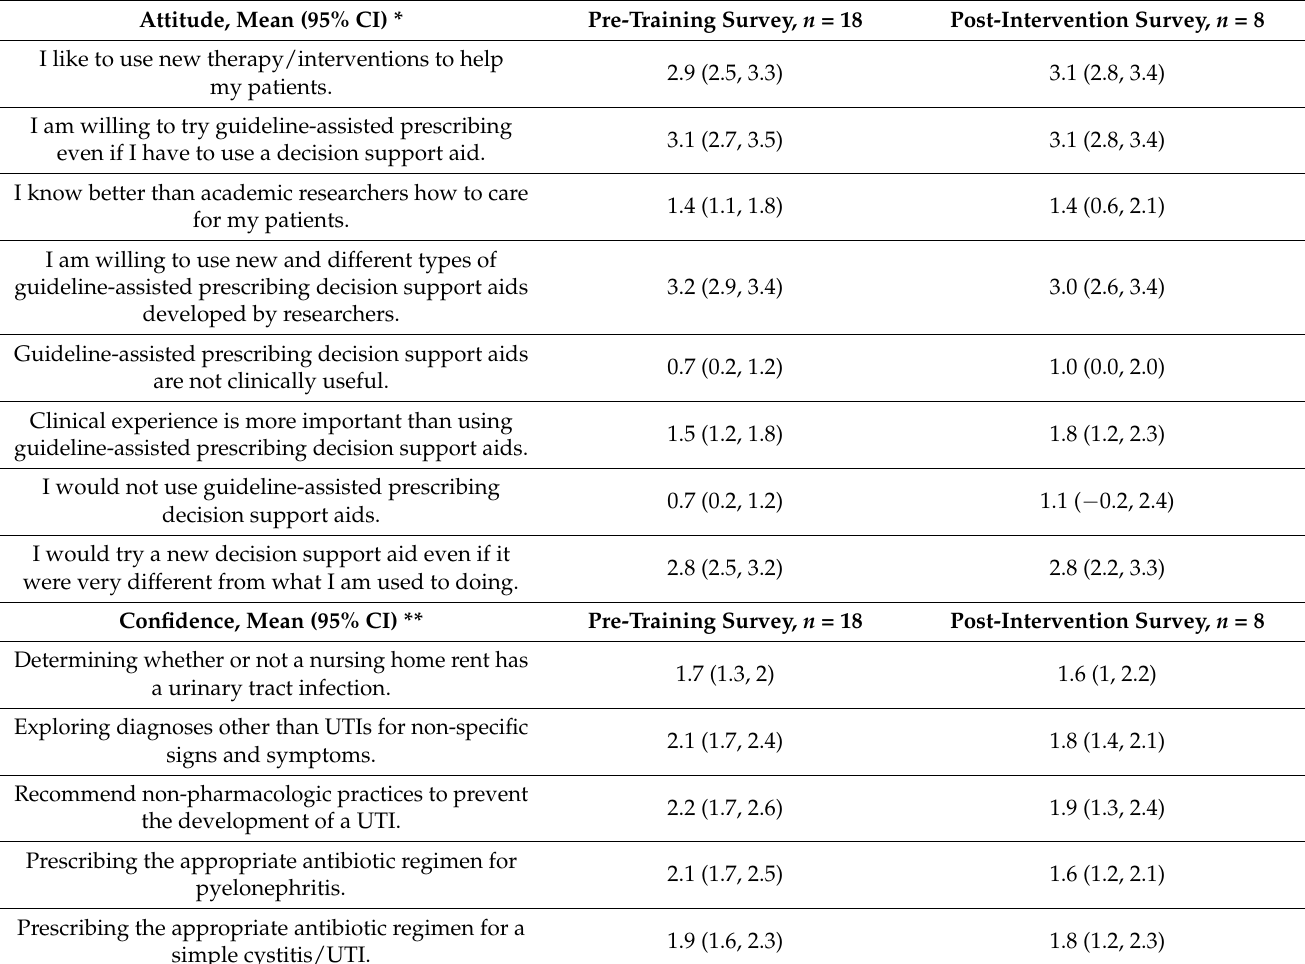
Table 1. Attitudes Toward UTIs and Clinical Decision Support and Clinical